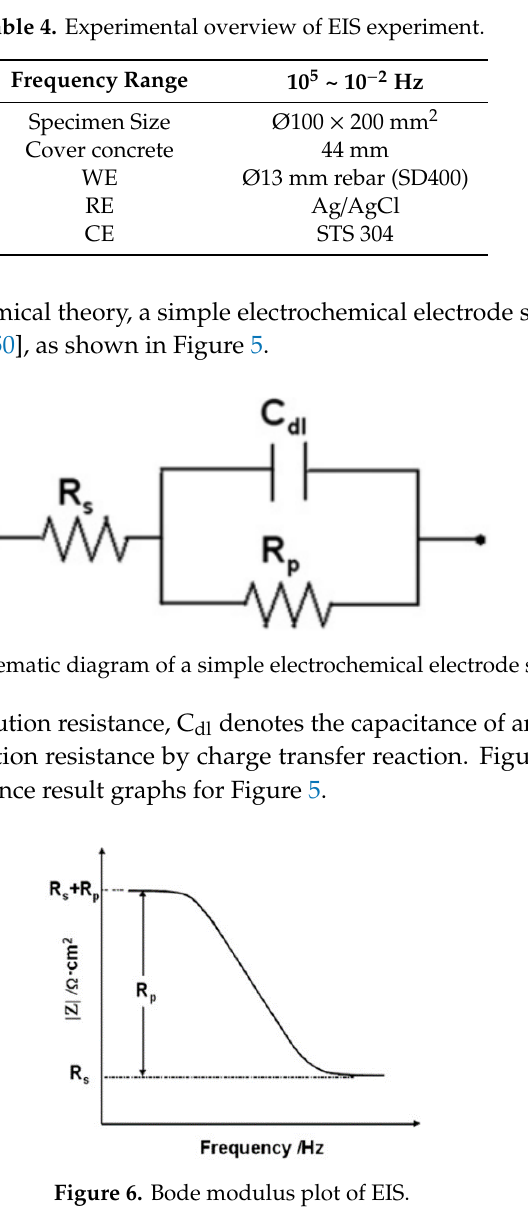
Figure 6. Bode modulus plot of EIS.